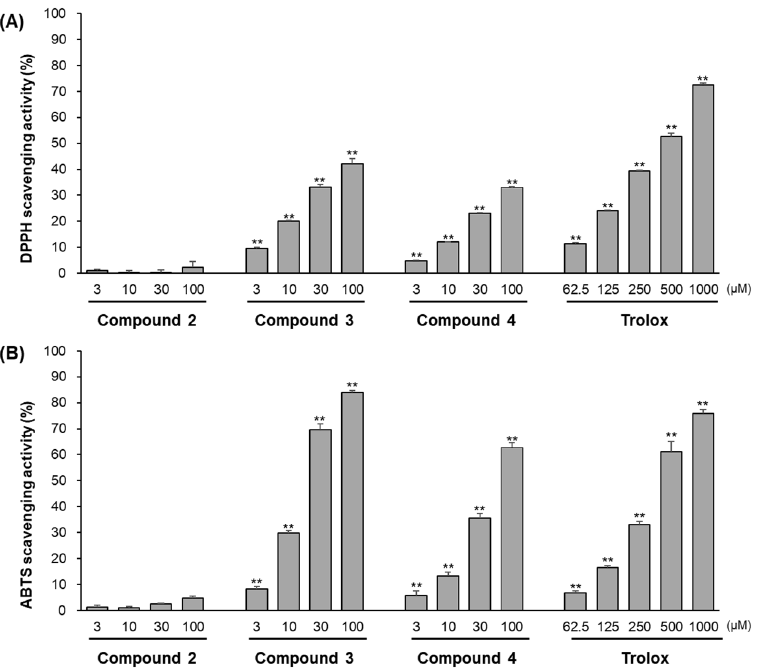
Figure 6. DPPH ( A ) and ABTS ( B ) radical scavenging activity of compounds 2 – 4 . The treated concentrations of compounds 2 – 4 were 3, 10, 30, and 100 µ M. Trolox was used as a positive control. Data are presented as the mean ± S.D. ( n = 3). ** p < 0.01 (compared with the vehicle-treated control).